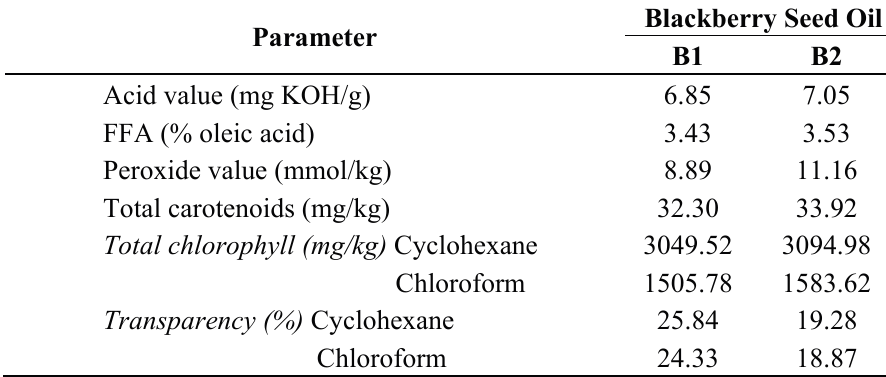
Table 4. Important quality parameters of blackberry seed oils grown in Serbia